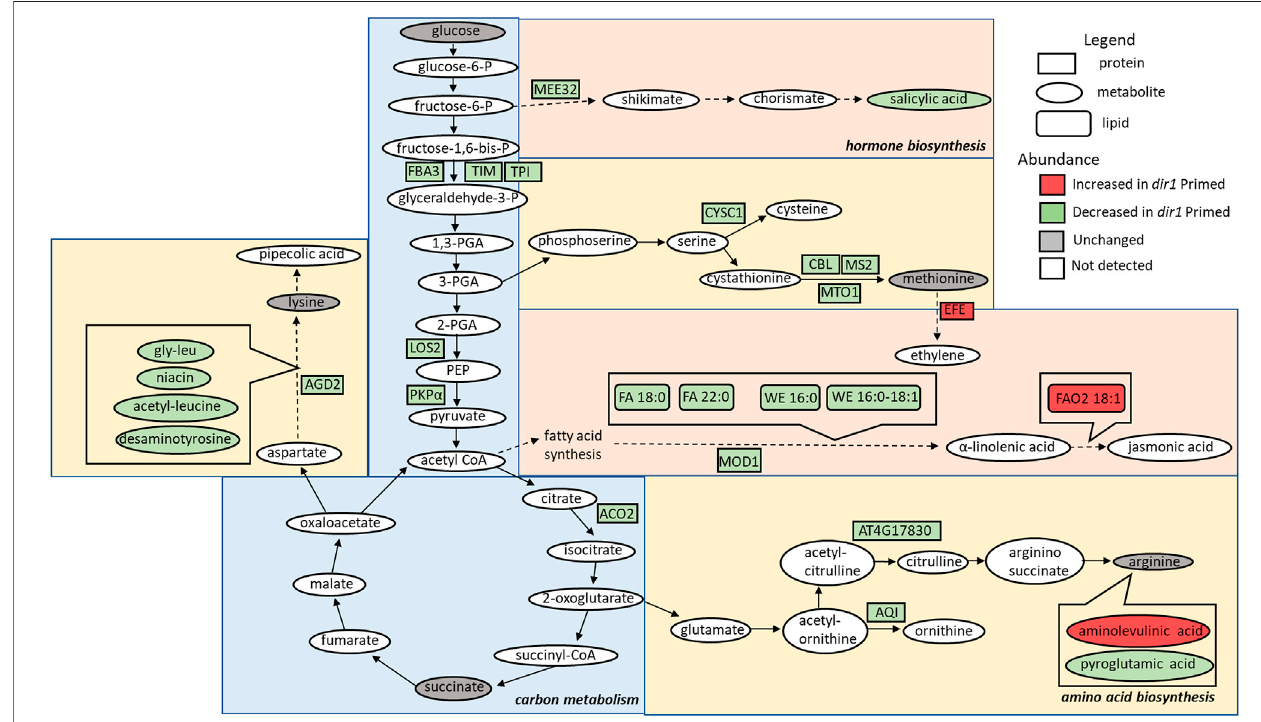
FIGURE 3 | Overview of the role of DIR1 in carbon metabolism, amino acid biosynthesis, and hormone biosynthesis in guard cells during systemic defense response. Loss of DIR1 results in altered abundance of proteins, metabolites, and lipids involved in carbon metabolism, amino acid biosynthesis, and biosynthesis of plant hormones and secondary metabolites. Proteins that were decreased in dir1-1 guard cells in the carbon metabolism metabolic pathway included FBA3, TIM, TPI, LOS2, PKP α , and ACO2. Proteins that were decreased in dir1-1 guard cells in the amino acid biosynthesis metabolic pathways included AGD2, CYSC1, CBL, MS2, MTO1, AT4G17830, and AQI, and decreased metabolites in these pathways included gly-leu, niacin, acetyl-leucine, desaminotyrosine, and pyroglutamic acid. One increased metabolite in dir1-1 guard cells in the arginine biosynthesis pathway was aminolevulinic acid. Proteins that were decreased in dir1-1 guard cells in the biosynthesis of hormones and secondary metabolites metabolic pathways included MEE32 and MOD1, and decreased metabolites and lipids in these pathways